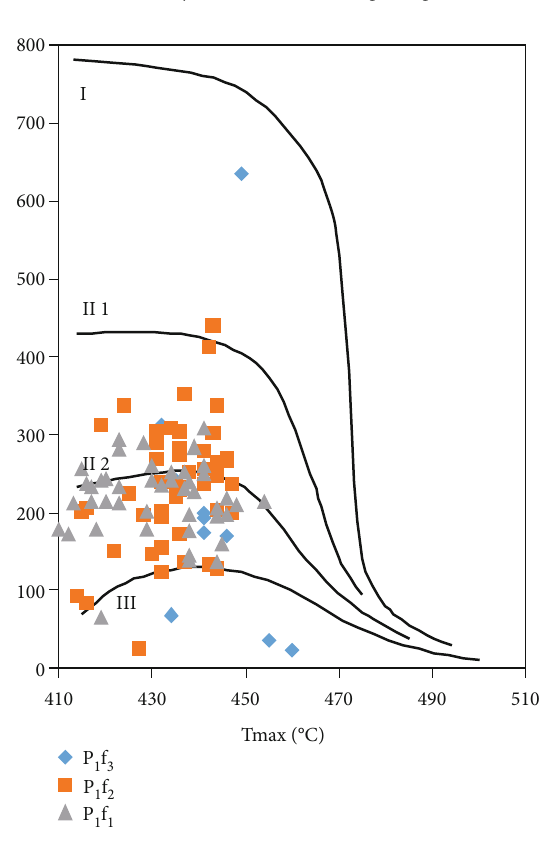
Figure 6: Maturity of shale in the Fengcheng Formation.